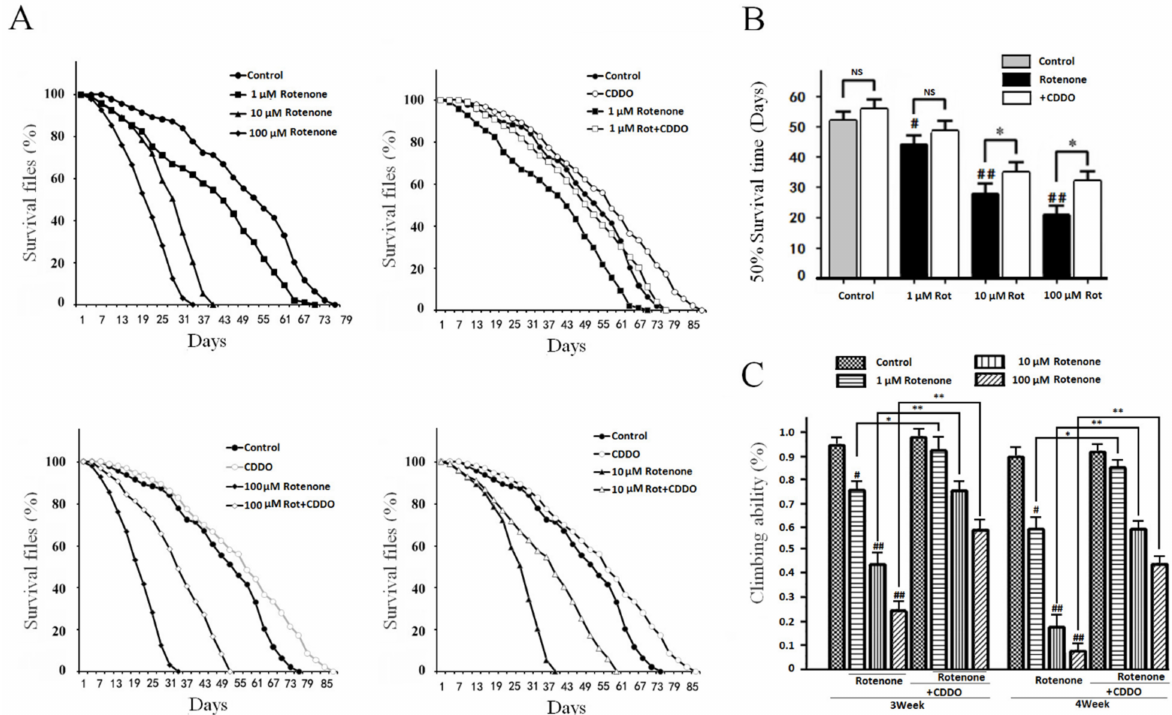
Figure 3. CDDO-Me treatment improved the survival time and motor ability in rotenone PD Drosophila model. ( A ) The fly survival curve. All three concentrations of Rotenone reduced survival time compared with the control group ( p < 0.05, 1, 10, and 100 µ mol/L Rotenone vs. DMSO control flies; the survival curves were analyzed by Log-rank test). The 10 µ mol/L CDDO-Me administration extended survival time in all three concentration of Rotenone ( p < 0.05 by Log-rank test, CDDO vs. 1, 10, and 100 µ mol/L Rotenone). ( B ) Half survival time. Rotenone reduced half survival time. ( # p < 0.05 and ## p < 0.01 vs. DMSO control flies). CDDO-Me significantly increased half survival time in 10 and 100 µ mol/L rotenone groups (* p < 0.05), but failed to extend half survival time in the control and 1 µ mol/L rotenone groups (NS p > 0.05). ( C ) Climbing ability assays. The climbing ability was assayed weekly, and the bar graph shows the results at the age of 3–4 weeks. Doses of 1, 10, and 100 µ mol/L rotenone significantly reduced climbing ability compared with the control group ( # p < 0.05 and ## p < 0.01), and CDDO-Me administration improved rotenone-induced motor dysfunction compared with the corresponding rotenone group (* p < 0.05 and ** p <